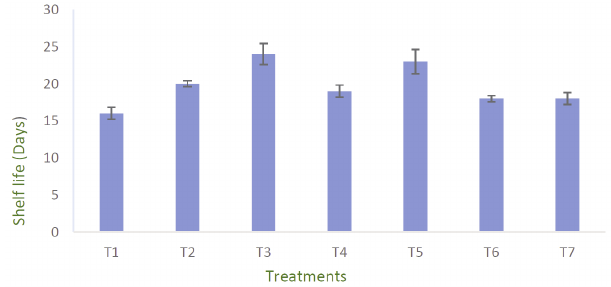
Fig. 3 ­ Effect of different packaging material on shelf life of tomato.